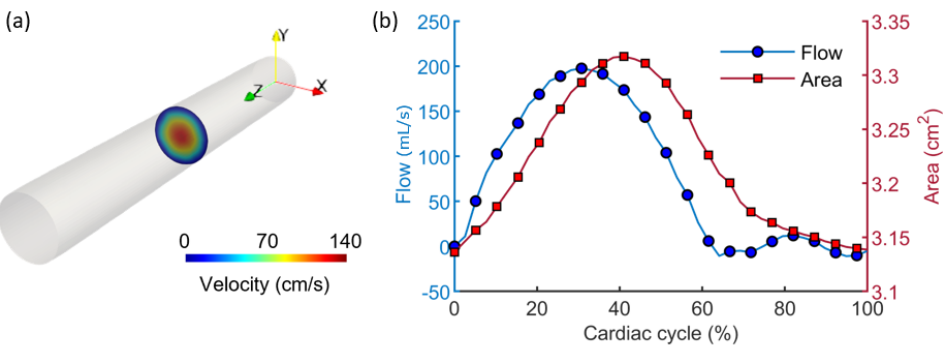
Figure 5. Extraction from the middle cross-section of the vascular model ( a ) of through-plane flow and area deformation along the cardiac cycle ( b ). This example is related to the FSI simulation with D d = 2 cm, Q p = 200 mL/s and E w = 1